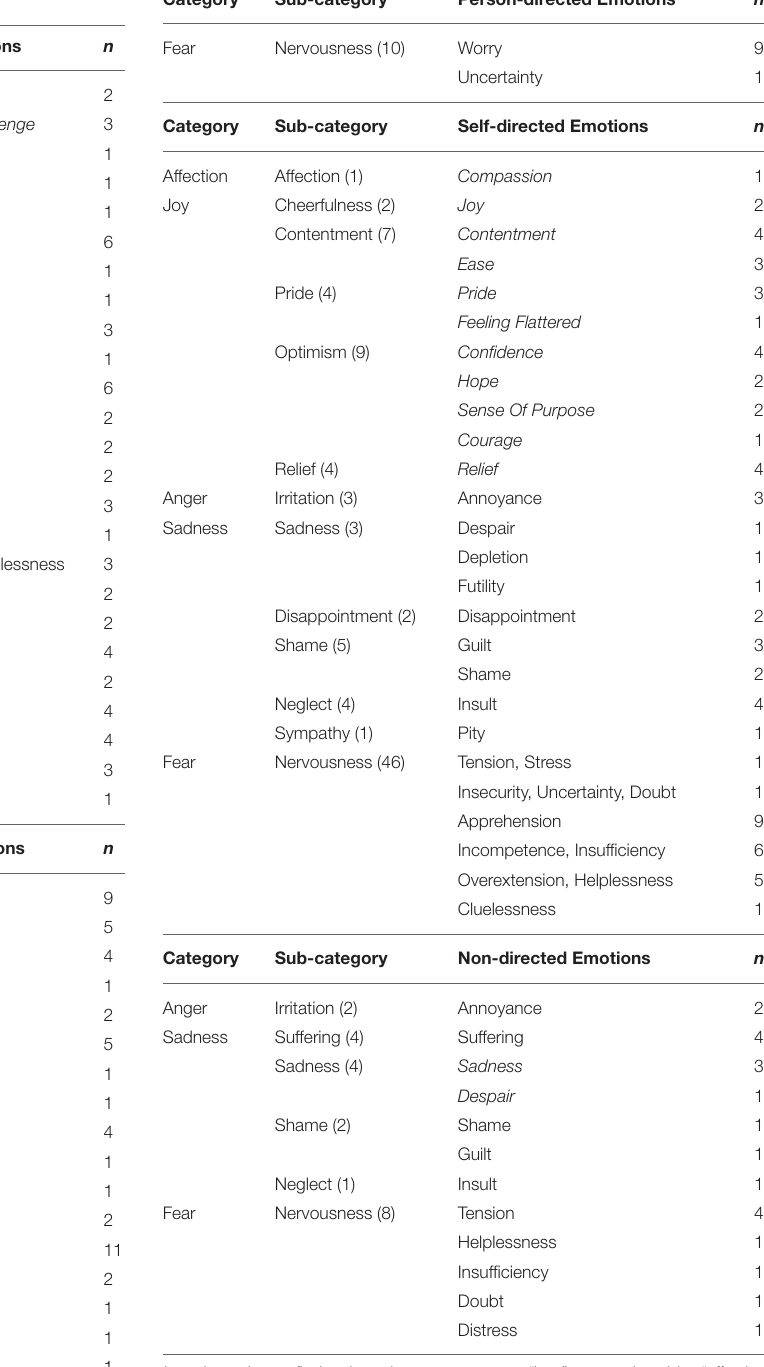
TABLE 3 | Object-directed, person-directed (i.e., patient), self-directed, and non-directed (i.e., emotion contagion) emotions grouped according to the categories and subcategories of Shaver et al.